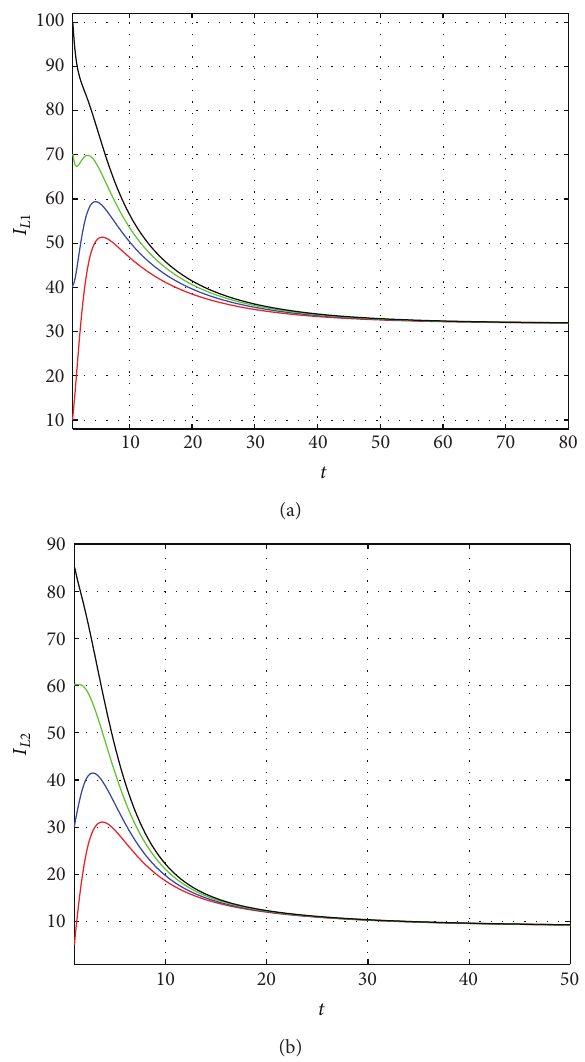
Figure 8: Time series of echinococcosis disease 𝐼 𝐿𝑖 , 𝑖 = 1, 2 , when the two patches are connected with 𝐷 1 = 0.2 , 𝐷 2 = 0.6